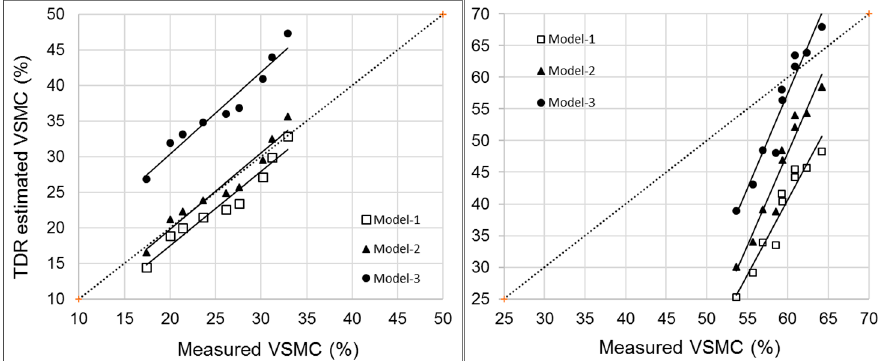
Figure 2. Relationship (1:1 graph) between the measured and TDR (Time-domain reflectometer)-estimated volumetric soil moisture content (VSMC) using three models; M-1, M-2, and M-3 for powdered biochar—BG p (left—0%; right—100%).